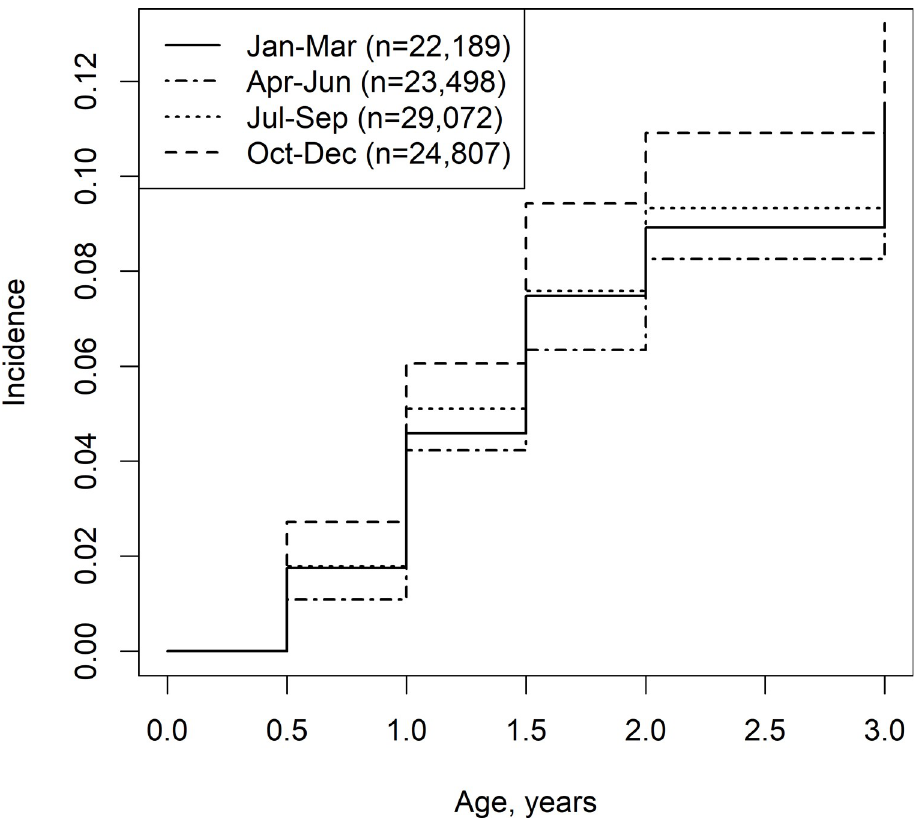
Fig 1. Birth season and the incidence of atopic dermatitis up to 3 years of age.